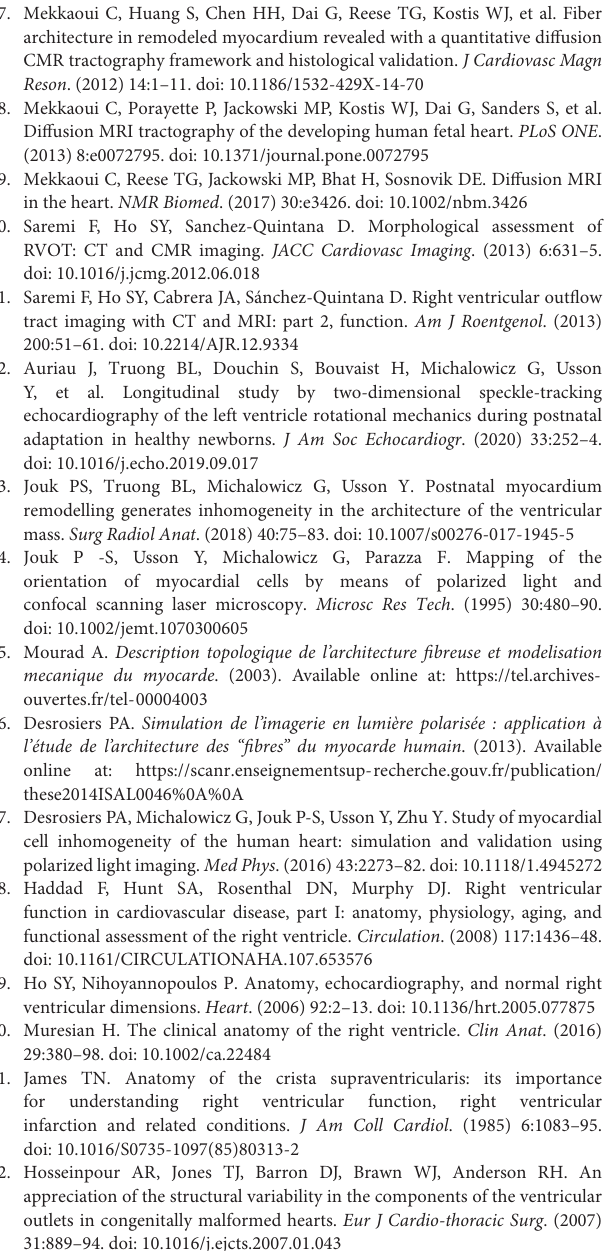
Supplementary Video 1 | Video sequence through the reconstructed texture maps of a control perinatal heart. Supplementary Video 2 | Video sequence through the reconstructed texture maps of a perinatal heart with a regular form of ToF. Supplementary Video 3 | Video sequence through the reconstructed texture maps of a perinatal heart with ToF and a severe hypoplasia of the outflow